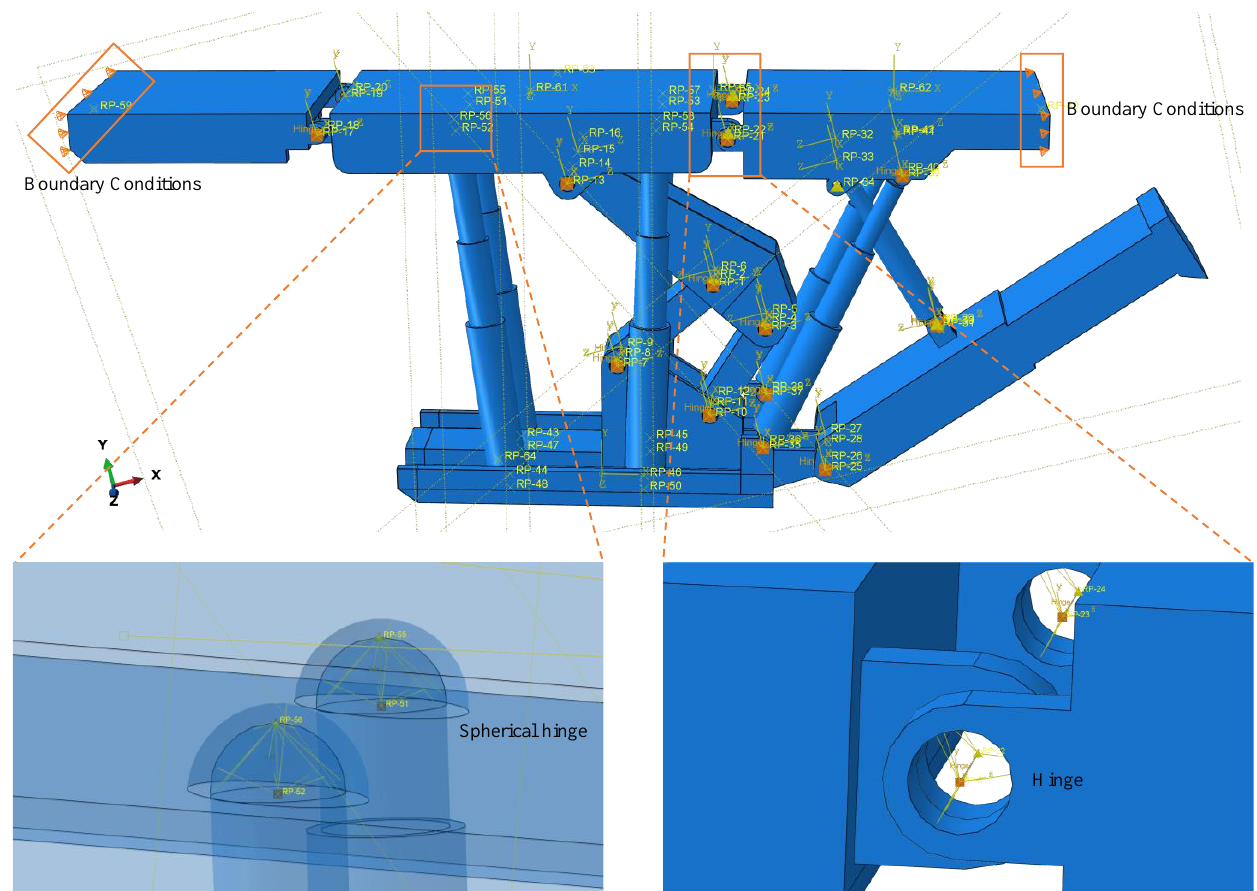
Figure 9. The boundary conditions of the model and the connection between the components.